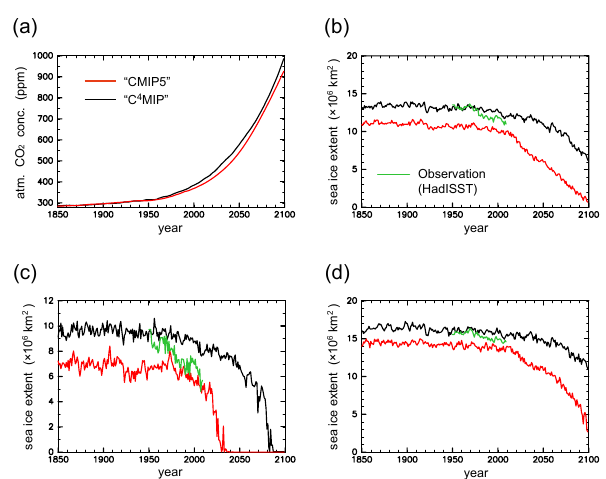
Fig. 1. Projected global annual mean atmospheric CO 2 concen- trations (a) , annual mean (b) , September mean (c) , and March mean (d) , sea-ice extent in the Arctic Ocean for “C 4 MIP” (black) and “CMIP5” (red) model versions. The green line is based on HadISST analysis. The sea-ice extent is defined as the total area with a sea-ice concentration greater than 15%. These results are not drift